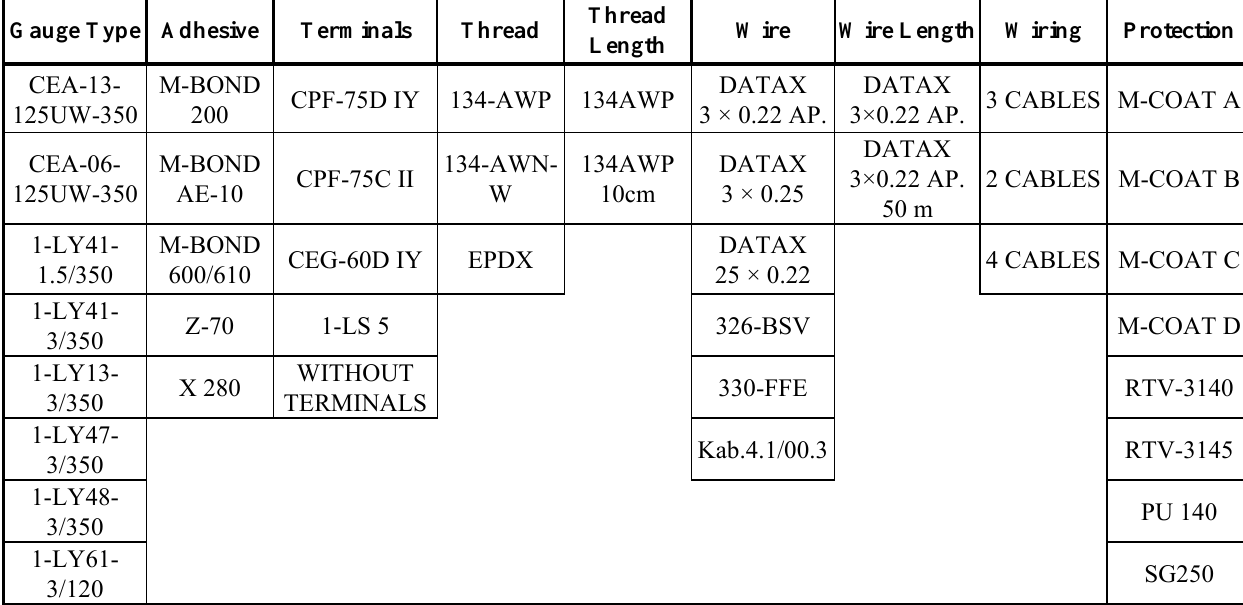
Table 1. Different parameters that may affect the reading of